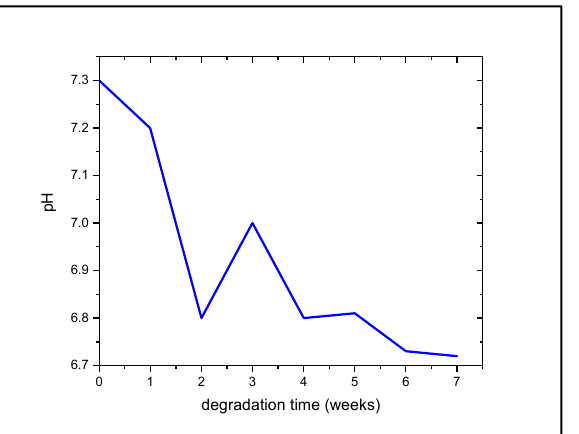
Figure 7. Monitoring pH change as a response of fs-laser-treated PCL degradation in PBS over 7 weeks.